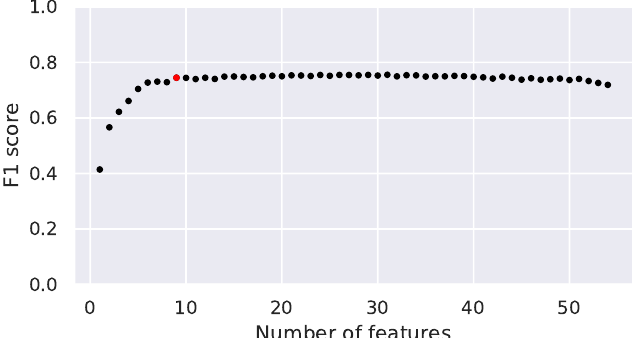
Figure 2. Feature selection for the Random Forest. The red dot marks the near-top accuracy achieved at 9